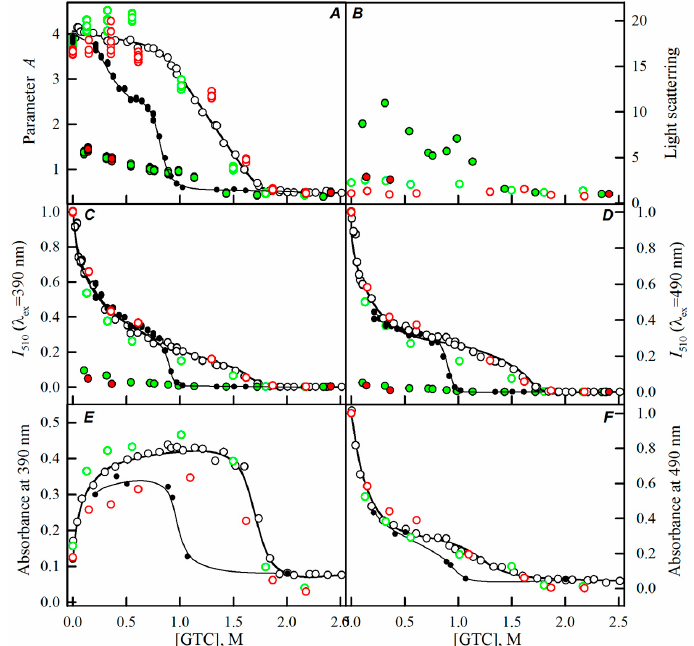
Figure 5. The effect of crowding agent Dextran-70 on the conformational changes of sfGFP induced by GTC. For more details see the legend of Figure 2. Applied concentrations of Dextran-70 were 24% (green circles), and 30% (red circles).